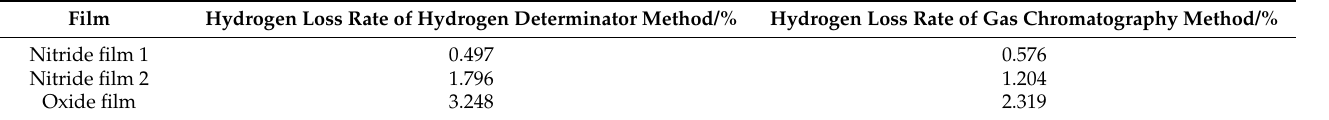
Table 6. Comparison of hydrogen loss rate after testing.